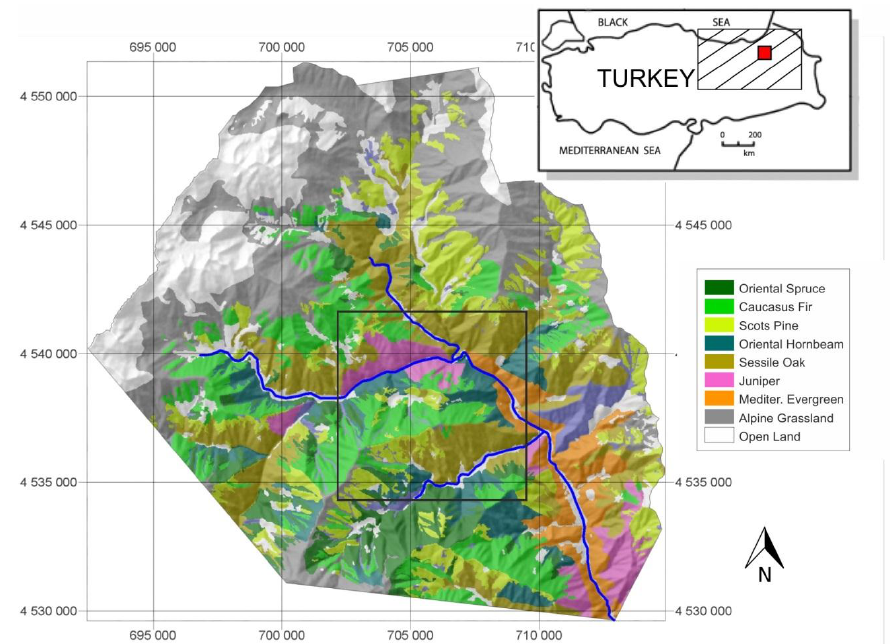
Figure 1. Study area and location. Rectangle represents the sample area for display purposes for the following